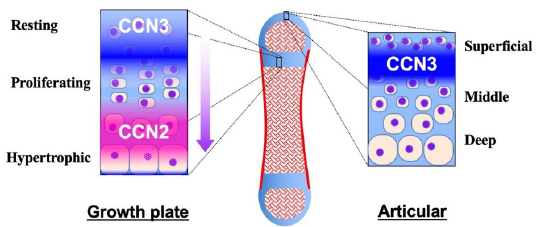
Figure 3. Distribution of CCN2 and CCN3 in the growth plate ( left ) and the articular cartilage ( right ) in a long bone ( middle ). Cartilage and bone tissues are shown in light blue and red, respectively. Distinct, but partly overlapping distribution of CCN2 and CCN3 is illustrated with gradation. Zones in the growth plate and articular cartilage are indicated. The arrow at the right of the growth plate indicates the direction of chondrocytic differentiation and bone growth. After the completion of bone growth, the growth plate disappears in humans, leaving articular cartilage at both ends. Articular cartilage stays until the end of the life, support- ing the locomotive activities, unless damaged or offended by osteoarthritis. In normal ar- ticular cartilage, CCN2 is barely detected [99], while CCN3 is produced by a limited pop- ulation of articular chondrocytes located beneath the superficial layer of the cartilage (Fig- ure 3, right panel) [96], which is far from the nutrition source, bone marrow or synovial fluid. CCN3 is induced therein by nutrition shortage and contributes to the retention of the quiescence and cellular stemness of chondrocytes around it [100]. However, along with aging, this restricted mode of CCN3 production in articular cartilage gradually changes. Immunohistochemical evaluation of mouse articular cartilage revealed that CCN3 was produced only by a limited number of the cells beneath the superficial layer of articular cartilage in young mice at one or two months after birth. In contrast, in aged mice at 7 months after birth, the majority of the chondrocytes in the superficial layer were found to produce CCN3. This age-related accumulation of CCN3 in articular cartilage was con- firmed by biochemical analysis of corresponding animals. Furthermore, significant posi- tive correlation was found between CCN3 expression levels and ages in human articular chondrocytes [8]. Contrarily, only a few chondrocytes were found to be producing CCN2 in aged mice through immunohistochemical analysis [8]. It is highly suspected that CCN3 induced by aging may repress the CCN2 production therein. The CCN3-dominant micro- environment of aged articular cartilage is supposed to be an adaptive response to the lo- comotive and nutrition conditions of senior individuals, but can be a risk factor for devel- oping osteoarthritis. As a matter of fact, cartilage-specific overexpression of CCN2 in mice adds resistance to age-related osteoarthritis development [99]. In general, damaged articular cartilage hardly regenerates without therapeutic inter- vention. Nevertheless, CCN2 was found to promote the regeneration of damaged articu- lar cartilage in rat osteoarthritis models [101,102]. Namely, exogenously applied CCN2 promotes the proliferation and differentiation of the remaining cells; furthermore, this CCN family member strongly represses the production of CCN3 through the metabolic regulatory system introduced in a previous section (Figure 4)[7,88]. As a consequence of this yin–yang regulation, articular chondrocytes are released from the quiescent stem-cell stage and are engaged in cartilage reconstruction encouraged by the molecular function of CCN2. As such, this mutual regulatory system is also useful for maintaining and recov- ering the integrity of the permanent cartilage in synovial joints.